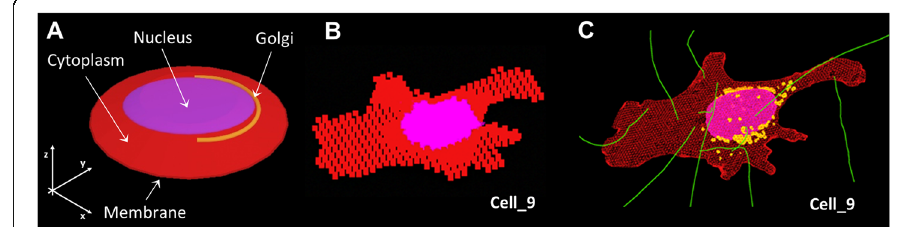
Fig. 1 Cellular shape modeling assumptions: a Truncated cone, b Voxelized geometry, c Polygonal mesh